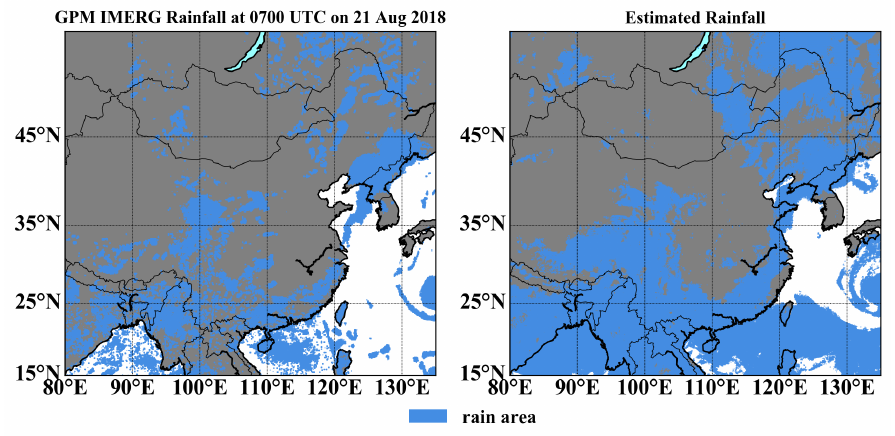
Figure 6. Comparisons of rain area delineation between the GPM ( left ) and RF model ( right ) at 0700 UTC 21 August